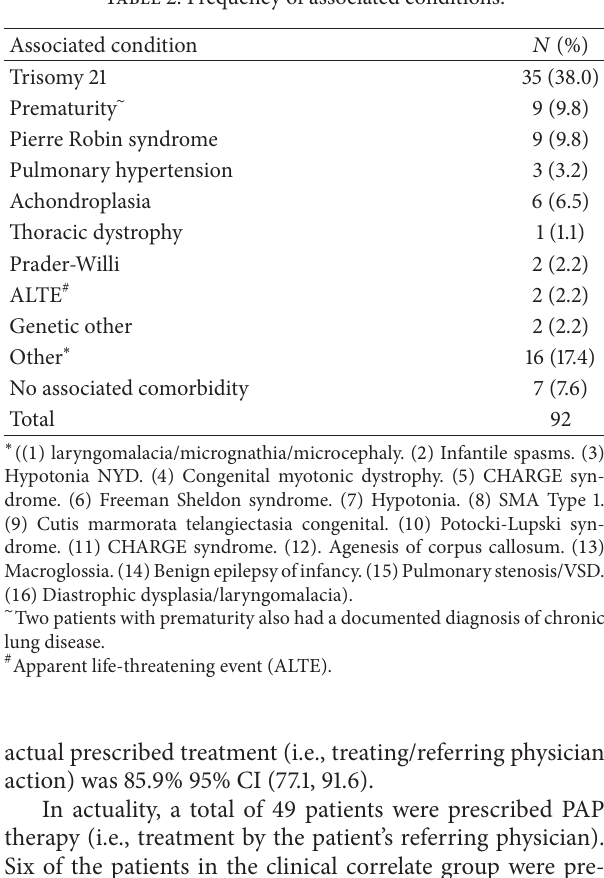
Table 2: Frequency of associated